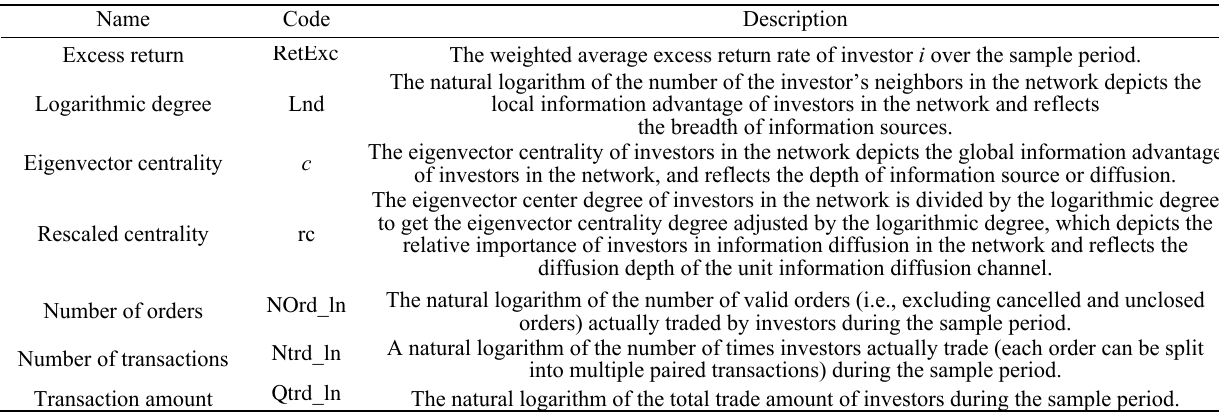
Table 1 Description of the correlated